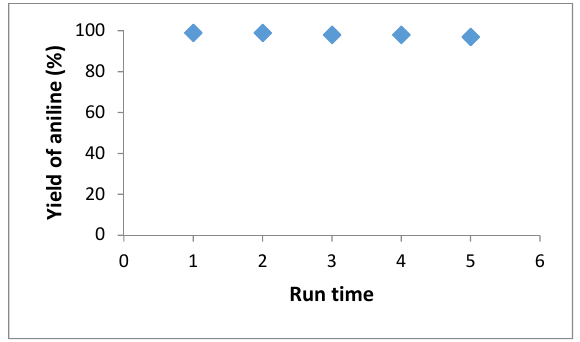
Figure 6. Recycling of Fe 9 TiO 15 @TiO 2 catalysts for the reduction of nitrobenzene to aniline. Reaction conditions: 5-mmol nitrobenzene, hydrazine hydrate, 50 mg catalyst (4 mol% Fe), 20 mL THF, 15 h, 100 ◦ C, yields were determined by GC using n-hexadecane as standard.